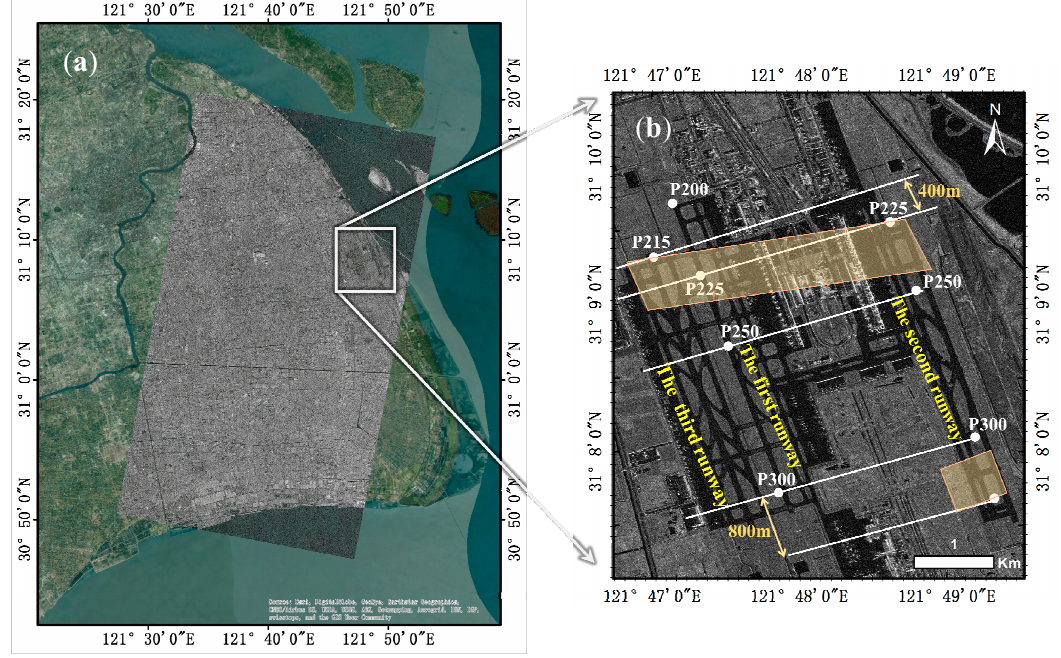
Figure 1. Area coverage of TerraSAR-X image ( a ) and the region of the paleo-river in mileage coordinates buried under the three runways ( b ).